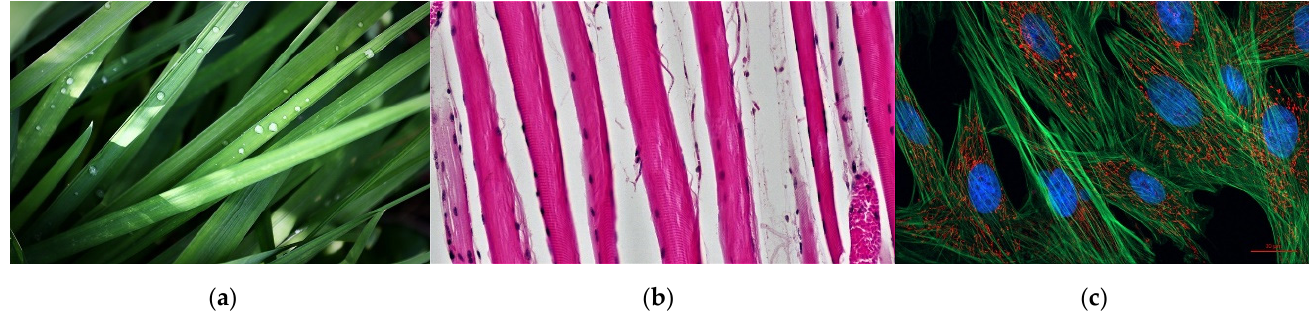
Figure 1. Instances of textures with clearly perceived directionality: ( a ) grass [3], ( b ) Muscle Tissue— Skeletal Muscle Fibers [4], ( c ) Indian Muntjac fibroblast cells [5].